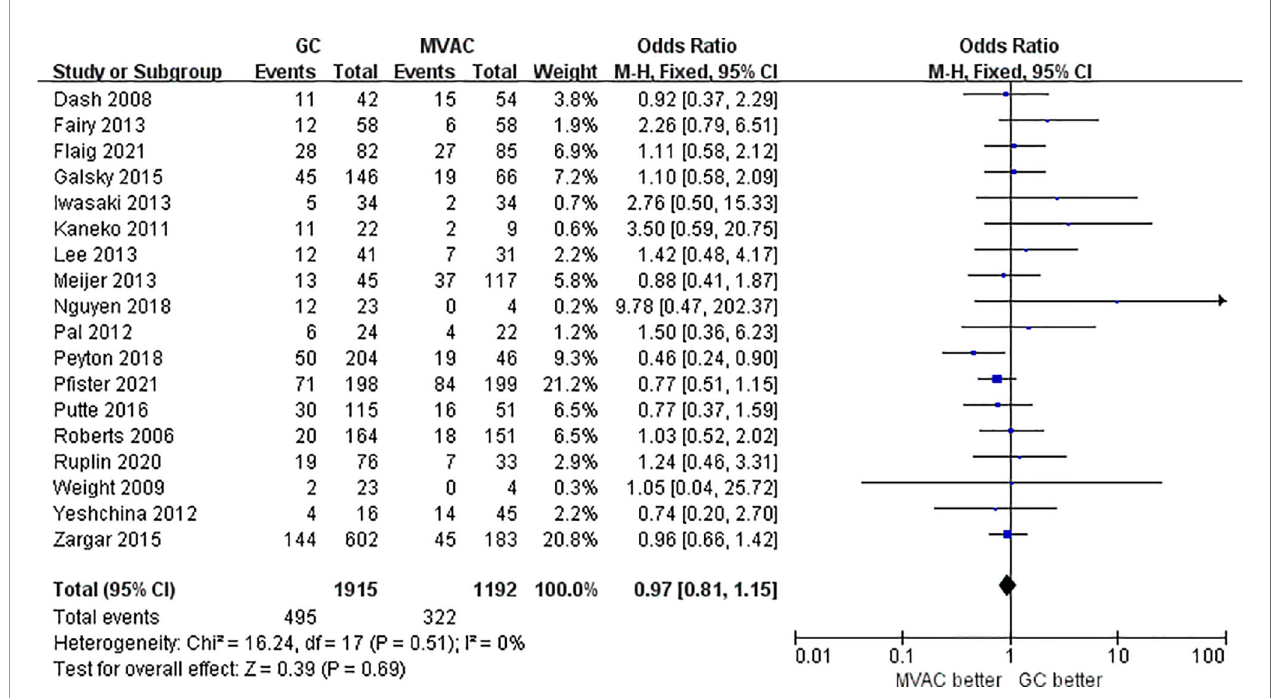
FIGURE 3 | Forest plot of pathological complete response (PCR) to GC versus MVAC.